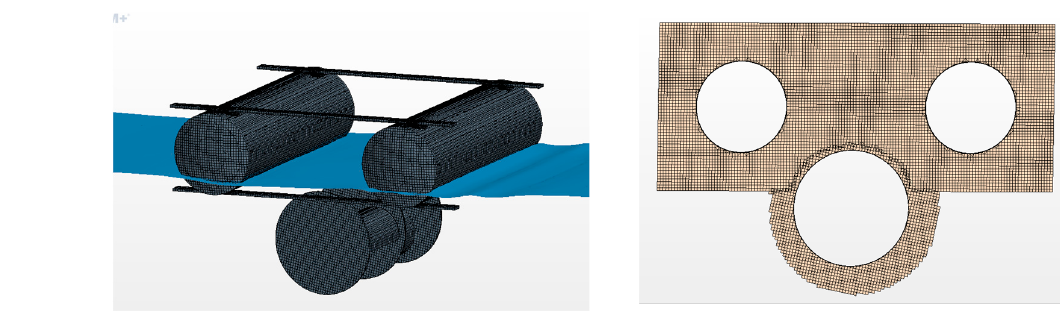
Figure 4. Three-dimensional Meshing of Breakwater. Table 4. Grid parameters.